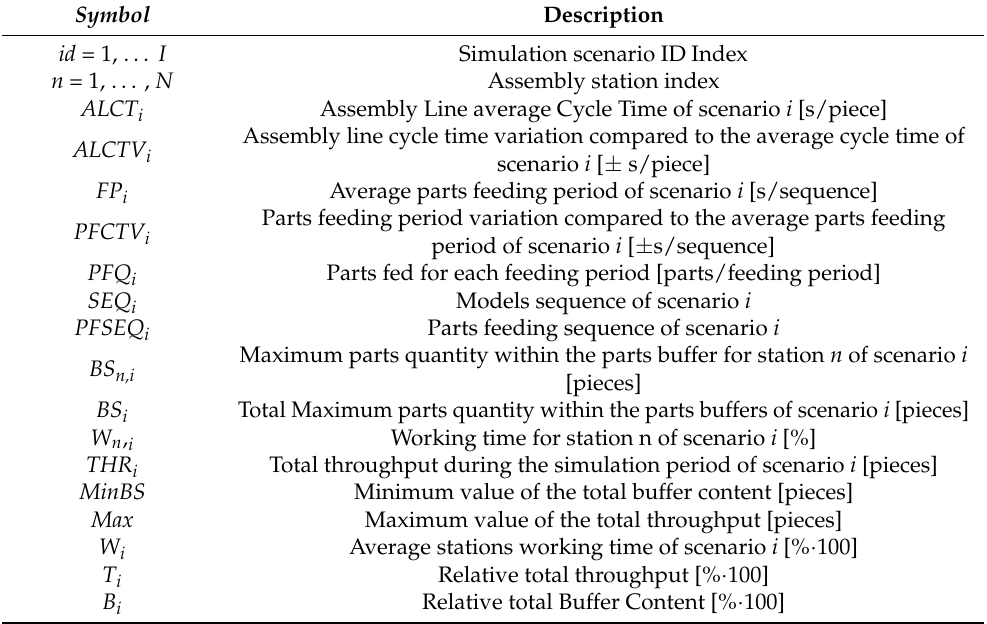
Table 1. Adopted notations.